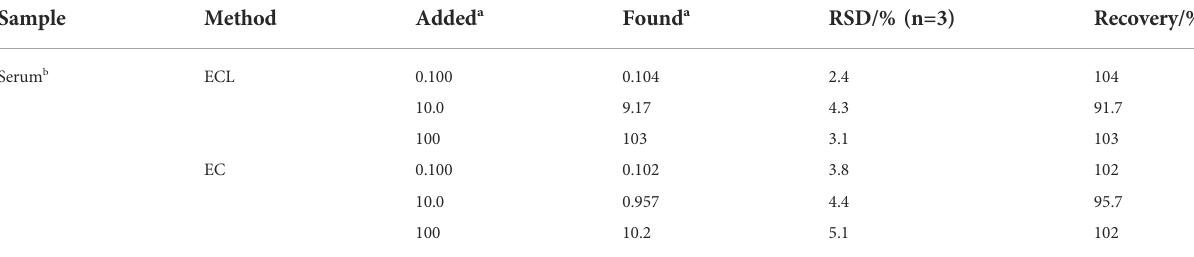
TABLE 2 Detection of arti fi cially added AFP in human serum.